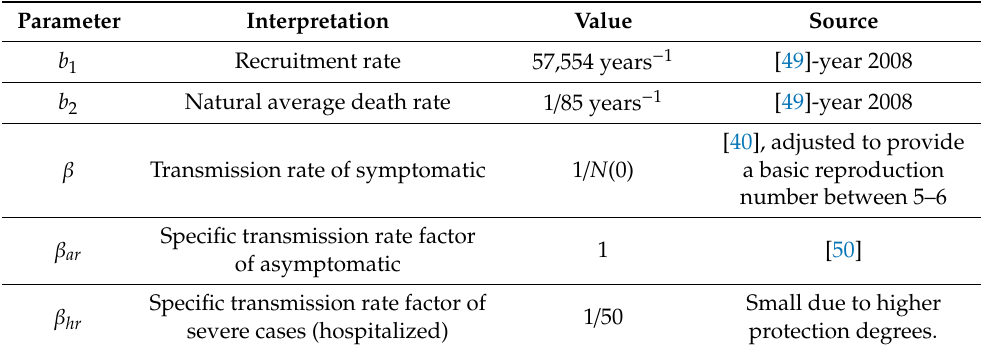
Table 1. Parameter values employed in